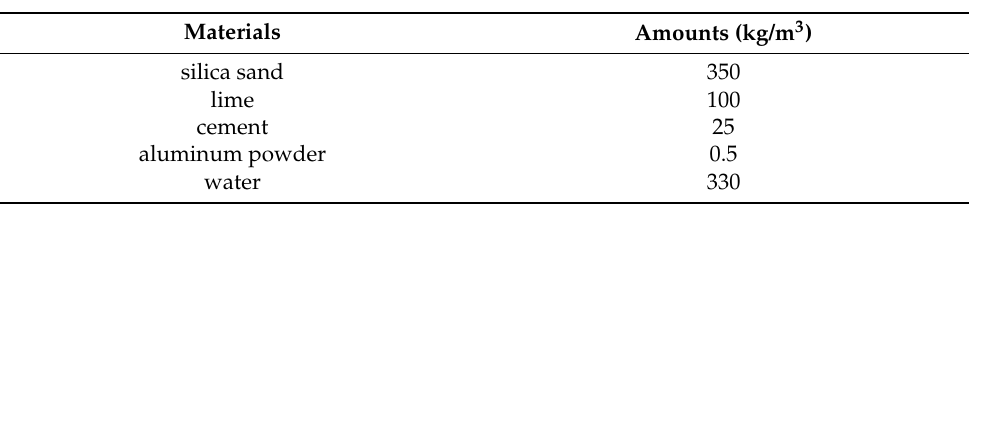
Table 2. AAC mix design with a density of 500 kg/m 3